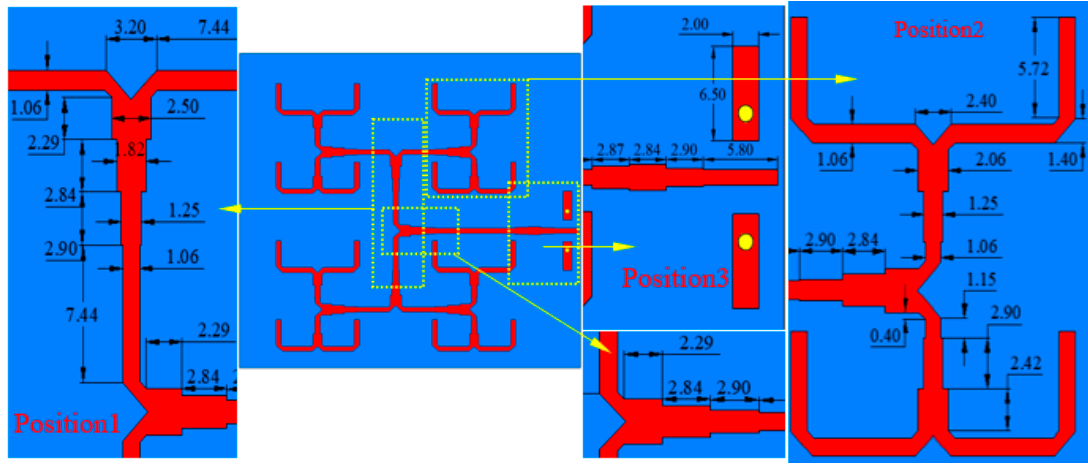
Figure 11. Structure of the corporate feeding network.